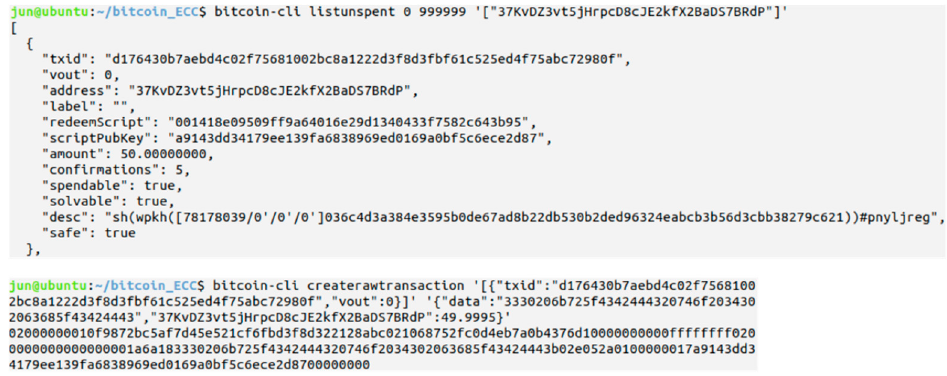
Figure 10. Create raw transaction in bitcoin.